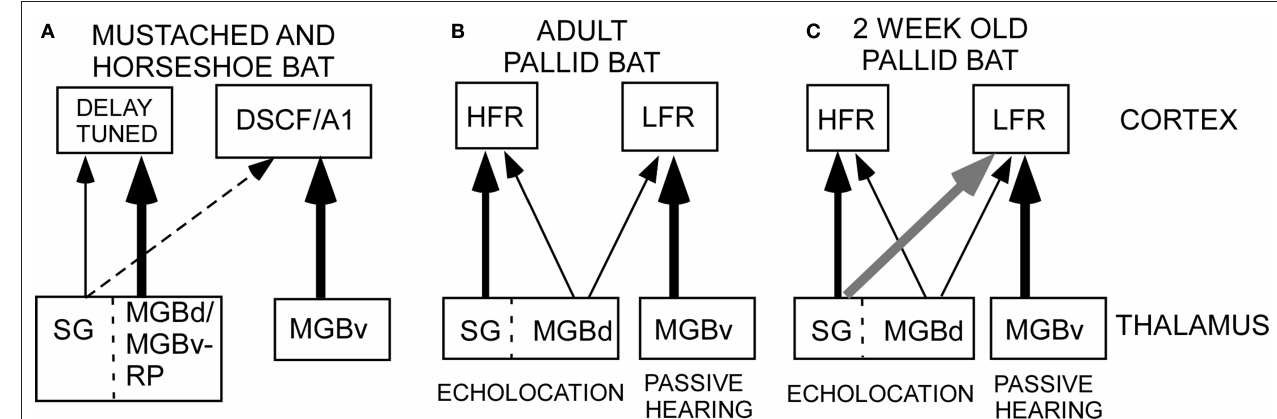
pallid bats, the HFR involved in echolocation behavior receives input from the SG and the MGBd, but not the MGBv. The LFR, involved in passive localization, receives input from the MGBv, but not the SG. Based on response selectivity in the auditory cortex, the SG → HFR pathway is involved in echolocation behavior while the MGBv → LFR pathway is involved in passive localization of prey- generated noise. (C) In a 2-week-old pallid bat pup, however, the pathways overlap. This is because the SG projects to both the LFR and HFR. The pup MGBv, as in adults, does not project to the HFR. Thus anatomically segregated pathways arise through postnatal refinement of initially overlapping